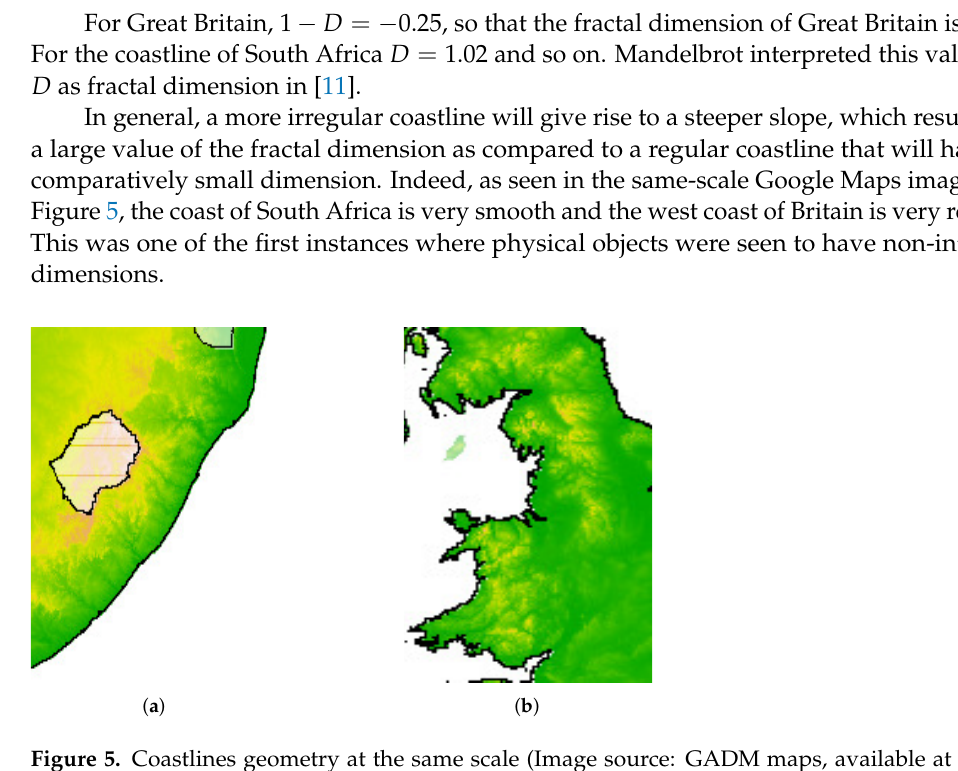
Figure 5. Coastlines geometry at the same scale (Image source: GADM maps, available at https: //gadm.org/maps.html, accessed on 20 October 2021). ( a ) Smooth South Africa, ( b ) Rough Great